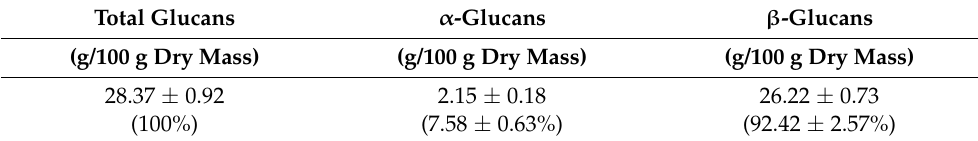
Table 2. Glucan content in powdered fruiting bodies of P. eryngii . Total